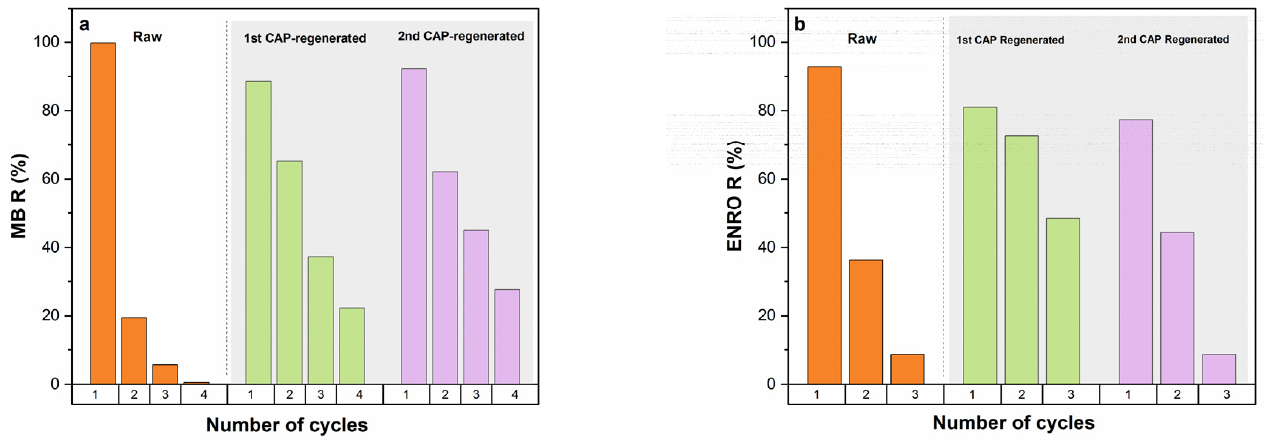
Figure 10. Adsorption cycles of raw, 1st CAP-regenerated HNC and 2nd CAP-regenerated HNC, for ( a ) MB and ( b ) ENRO (C ENRO = 40 mg/L, C MB = 40 mg/L, pH = 6.2, C HNC = 2 g/L, T = 28 °C).